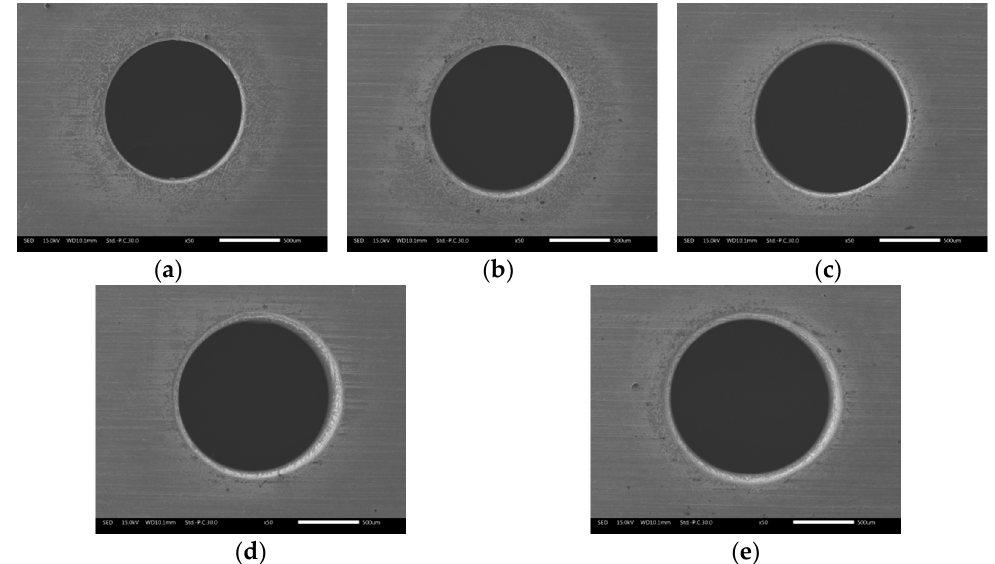
Figure 11. Variation of exit diameter and circularity error with applied voltage in electrochemical reaming.